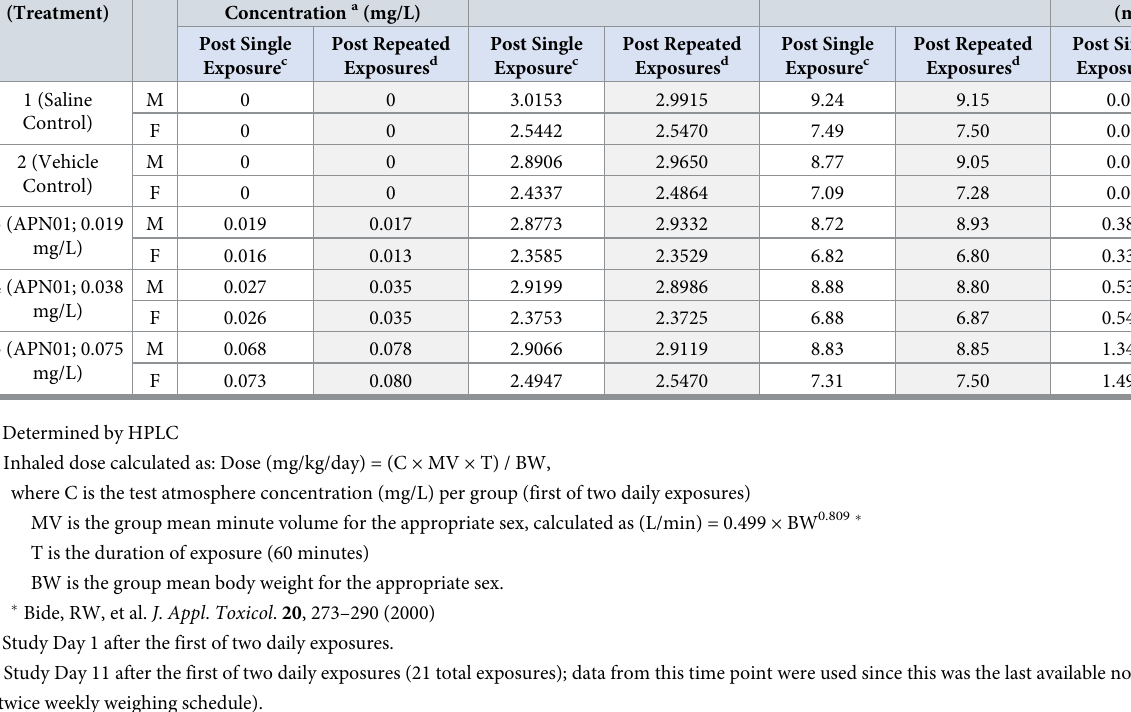
Table 3. Calculated inhaled dose levels. At all concentrations, the inhaled APN01 dose exceeded SARS-CoV-2 neutralizing concentrations. This was the case for both the initial administration and after repeated exposures. Group